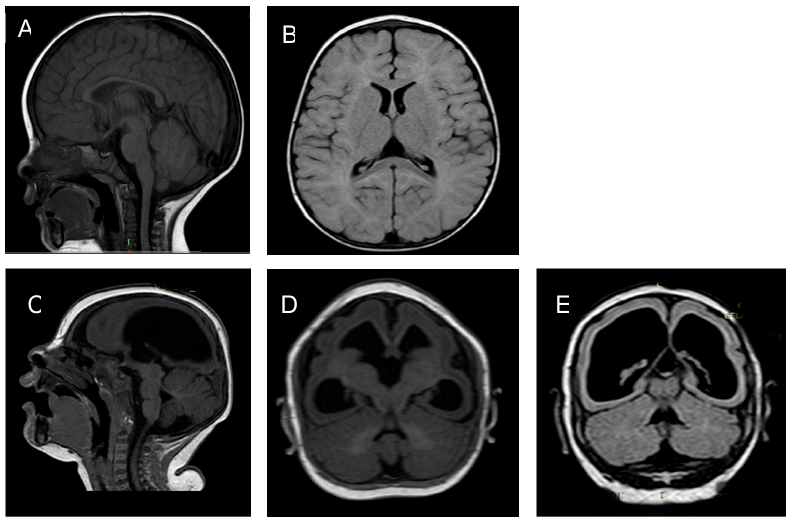
Figure 1. Twin A: Panel A : Brain MRI at 7 months of age sagittal T1 showing normal brain cortex formation and thickness, normal corpus callosum, and posterior fossa. Panel B : Axial T2 Fluid Attenuated Inversion Recovery (FLAIR) showing normal ventricular size. Twin B: Panel C : Brain MRI at 7 months sagittal T1. Panel D axial T2 FLAIR. Panel E axial T1. Images show a thin cortical mantle, ex vacuo enlargement of lateral ventricles, reduced cortical folds, and hypogenesis of the corpus callosum.